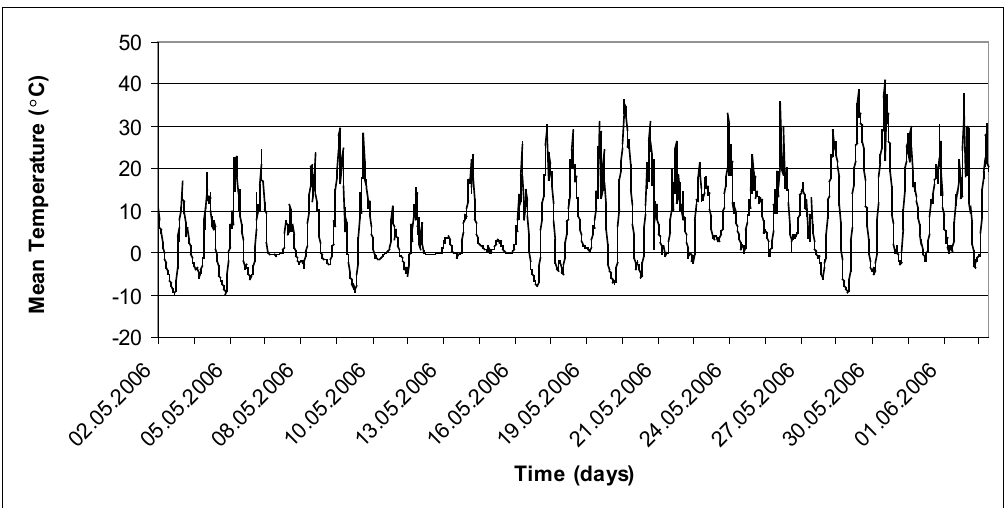
Fig. 4. Mean soil-surface temperatures recorded by four probes every 30 minutes from 2 May to 3 June 2006 on spring grazing ground of Chisana